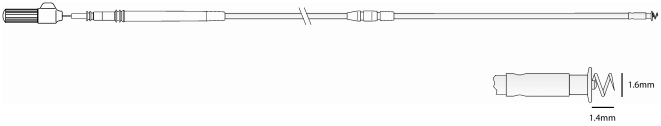
Illustration of KY5 electrode.Screw length 1.4 mm with 1.5 turns; screw diameter 1.6 mm; screw surface area 7.2 mm2. Screw is Eligiloy with Iridium oxide coat. Total electrode length 580 mm.